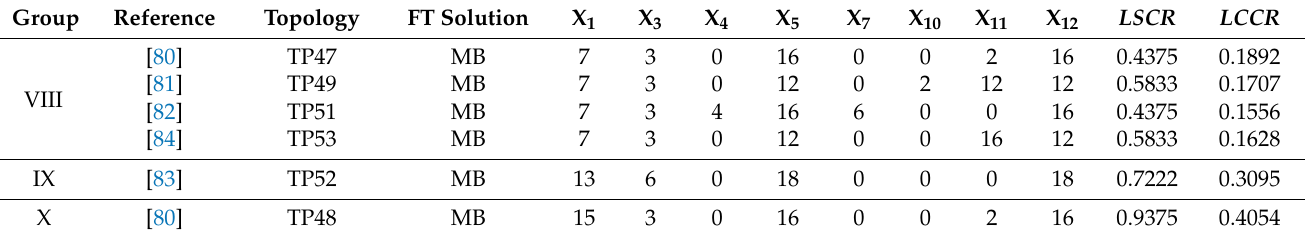
Table 2. Comparison of single-phase FT MLIs based on modules in terms of LSCR and LCCR